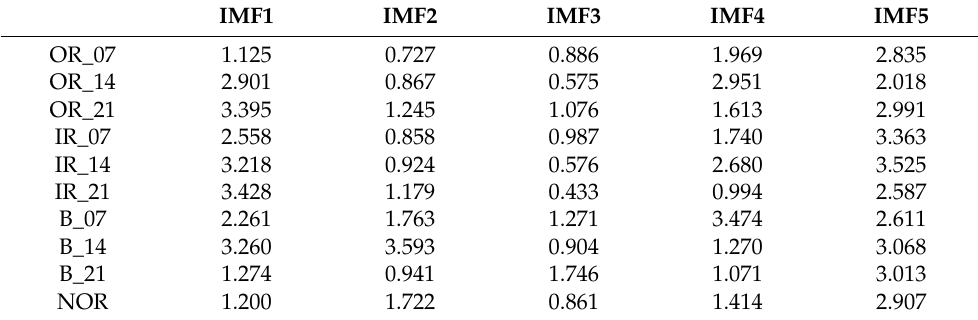
Table 2. The distribution of attention entropy about different types of rolling bearing